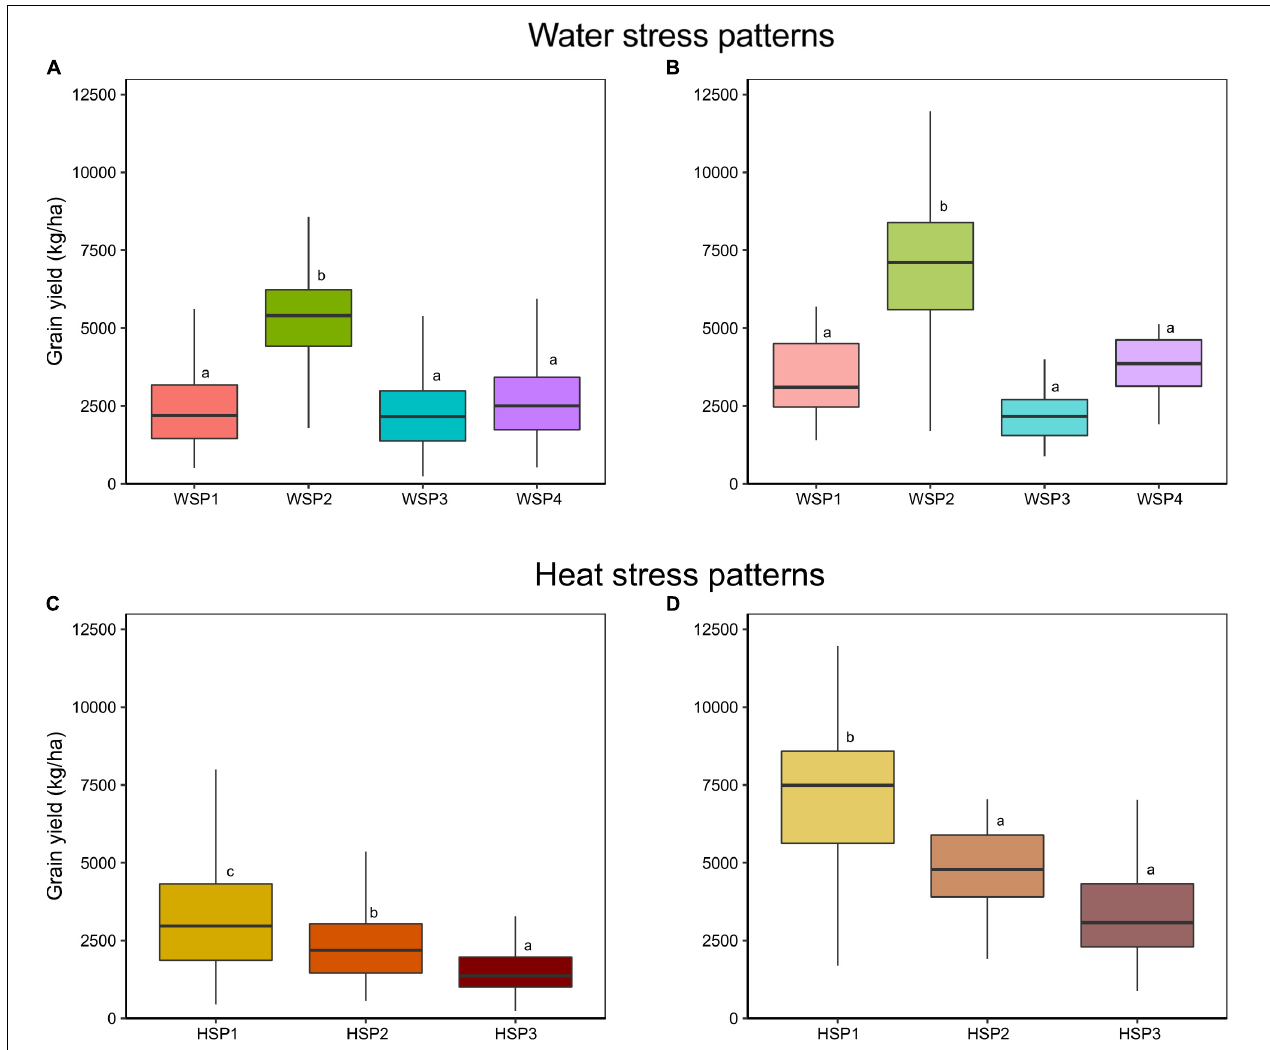
FIGURE 3 | Simulated (A,C) and observed (B,D) yield distribution of the hybrids Hybrid 1 and Hybrid 2, within each (A,B) WSP and (C,D) HSP. Different letters inside each graph stand for significant differences in Student’s t